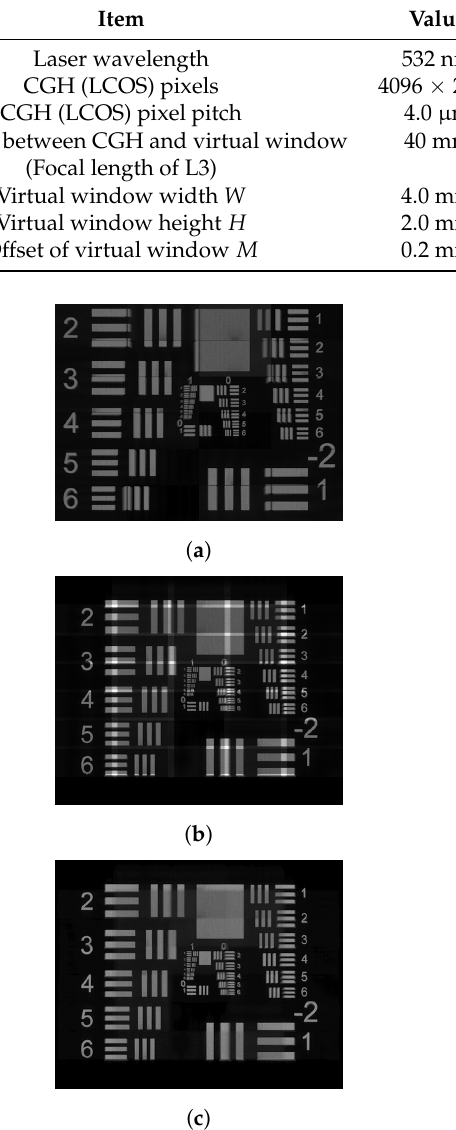
Figure 6. Reconstructed images from USAF-1951 resolution chart. ( a ) Normal output without overlapping; ( b ) 10%, 10% overlapping without filter; ( c ) 10%, 10% overlapping with